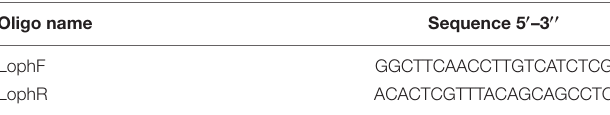
TABLE 1 | Primers designed to be specific to Lophelia pertusa and used in the ddPCR